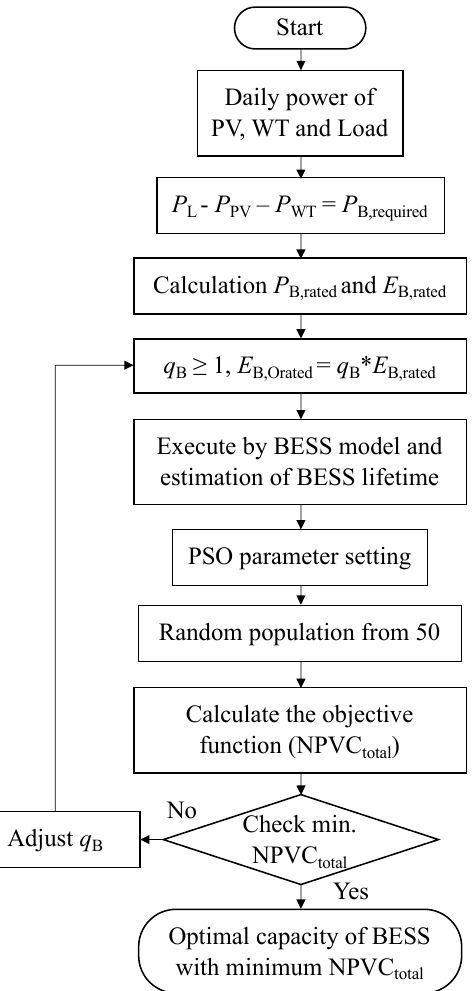
Figure 4. Flowchart for determination of the optimal BESS capacity. The q B value is changed from 1 to 5 in 0.001